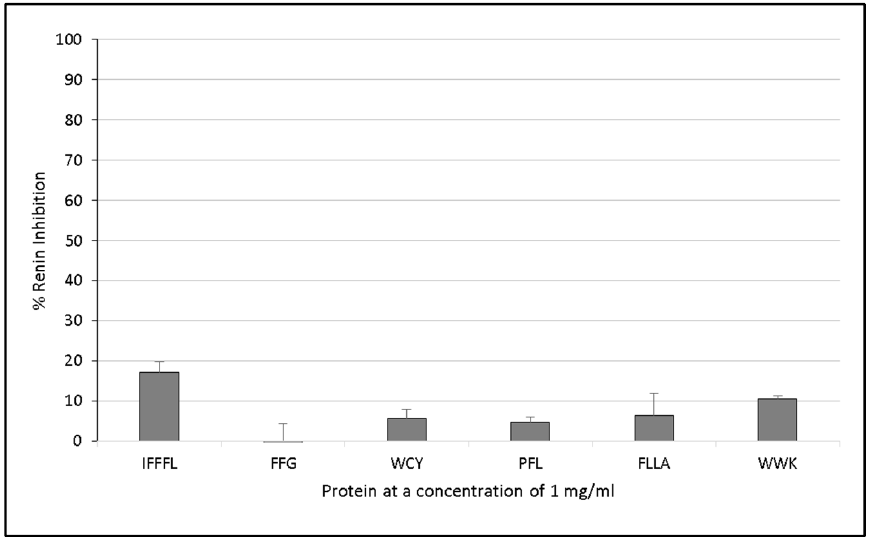
Figure 3. Renin inhibition assay of several chemically synthesised peptides from predicted oat protein hydrolysates following in silico digestion with the proteases papain and ficin. Peptides were assayed at a concentration of 1 mg protein/mL. Values are the mean of triplicate samples.